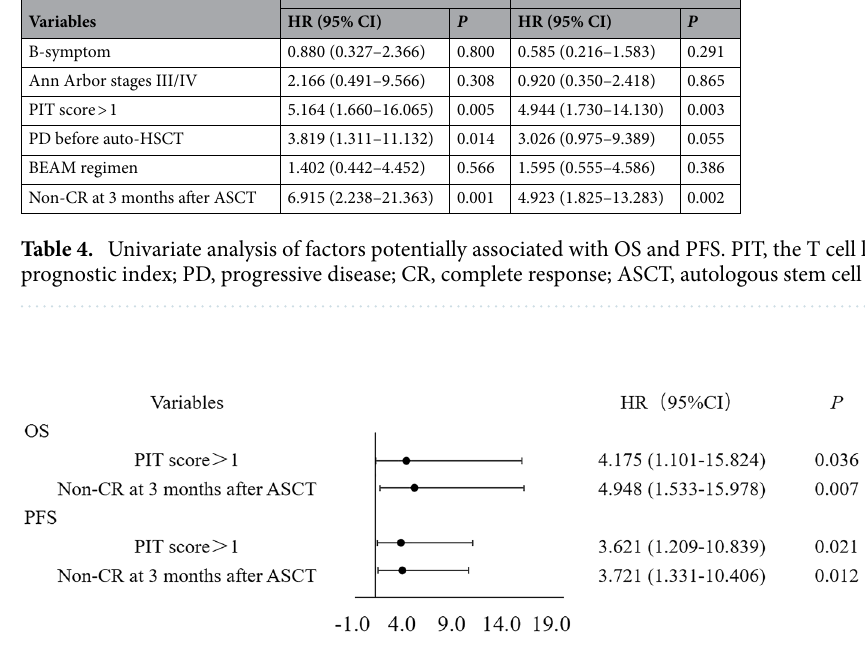
Figure 3. Multivariate analysis of factors potentially associated with OS and